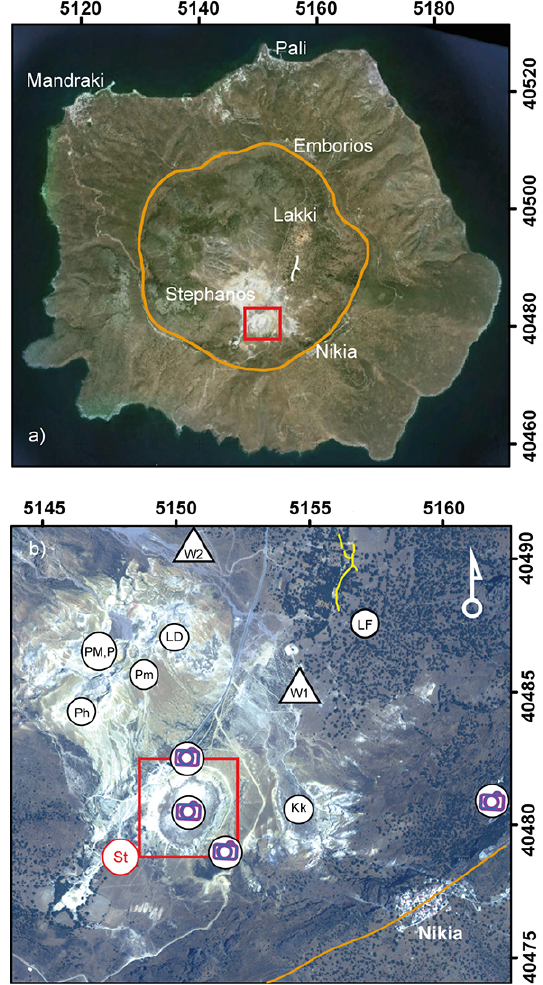
Fig. 1. (a) Nisyros Island. Coordinates are in UTM, zone 35, grid ticks are at 2km. The brown line marks the border of the caldera. Inside the caldera: the red square shows the position of the Stefanos crater; the white line highlights the 2001–2002 fissure at the Lakki plain. Other toponyms outside the caldera indicate the villages on the island. (b) Satellite image (WV02) showing the main volcanic features inside the caldera; grid ticks are at 500m. The red square indicates the Stefanos crater labeled St; other labeled sites are the Kaminakia crater (Kk), the Lofos dome (LD), the nested Polybotes Megalos and Polybotes craters (PM,P), the Polybotes Micro crater (Pm) and the Phlegeton crater (Ph). LF is the fissure in the Lakki plain. The camera icons point out the position where IR and OP images were collected, inside/outside of the Stefanos crater and at the caldera border (brown line). W1 and W2 indicate the positions of two geothermal